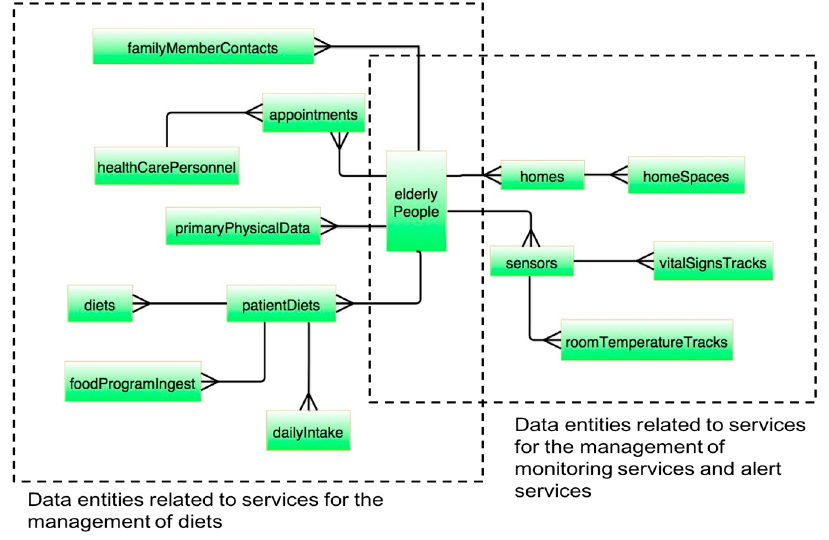
Figure 6. Data structure.